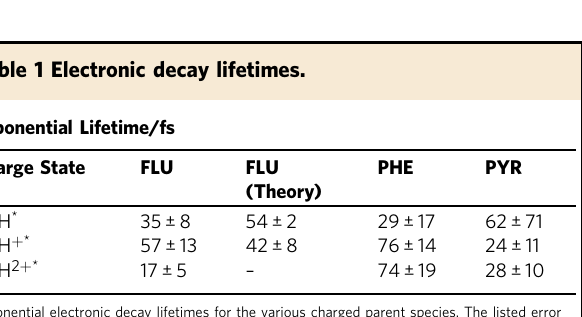
Exponential electronic decay lifetimes for the various charged parent species. The listed error values refer to the fi t errors. The pump laser pulses are expected to populate an ensemble of electronic states, as described and modeled in Supplementary Note